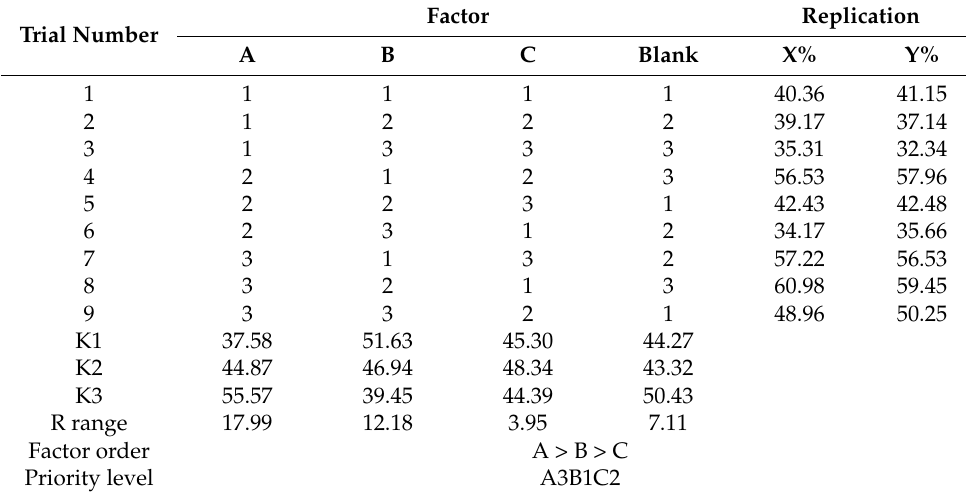
Table 2. Orthogonal array experimental results for papain